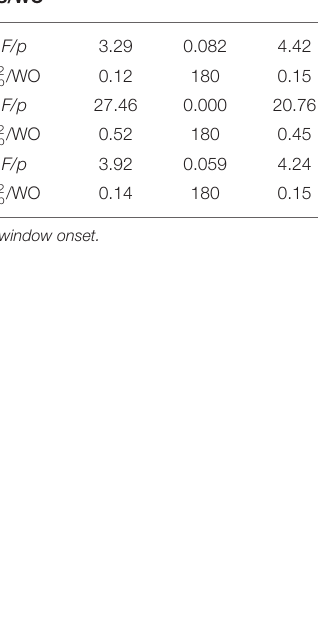
TABLE 5 | Significant N300, P3b, and N400 effects (site) within a 20-ms time window ( N =